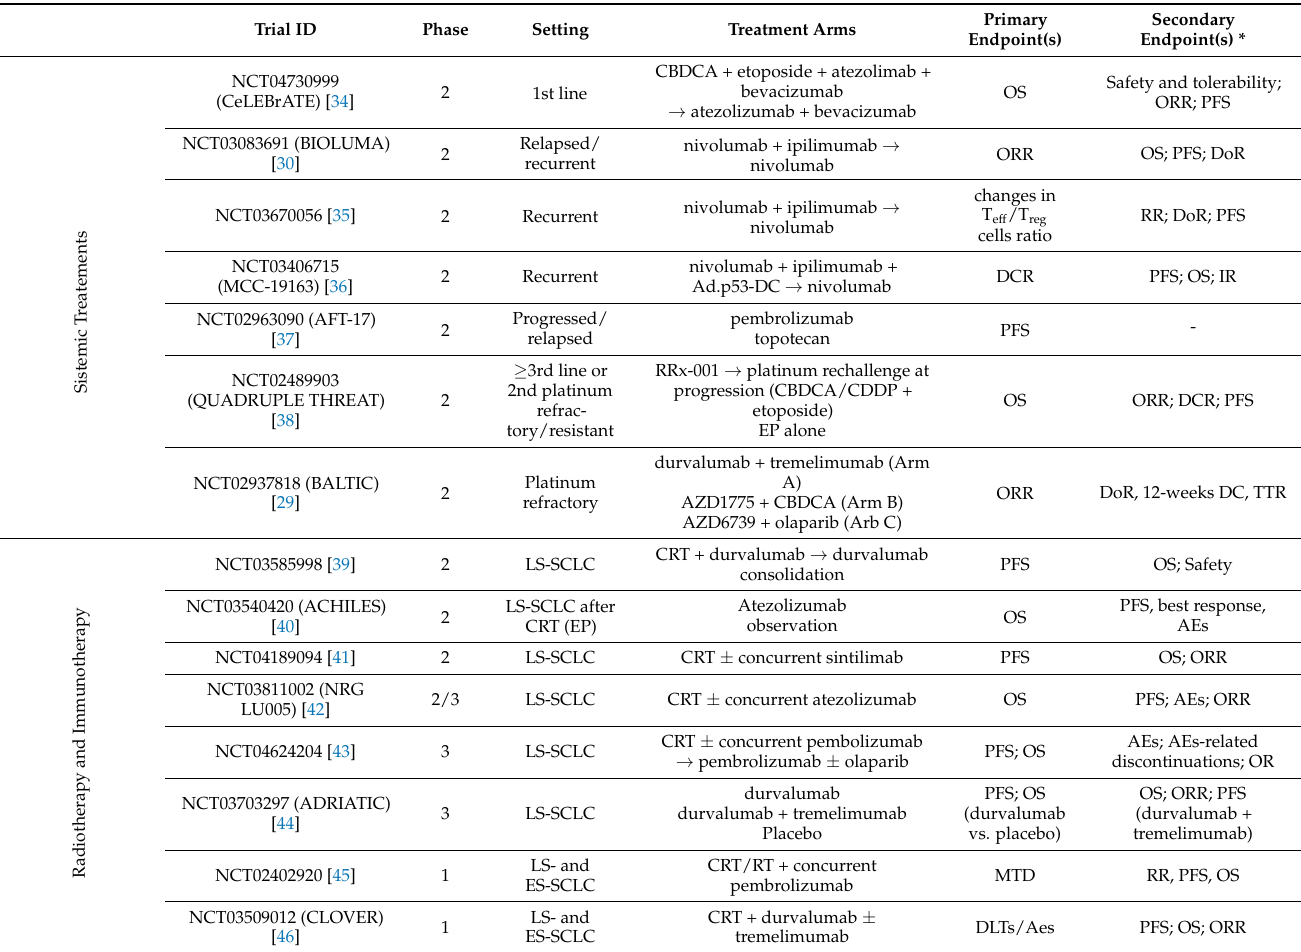
Table 2. Main ongoing clinical trials about immunotherapy combination/single agents and combina- tions with